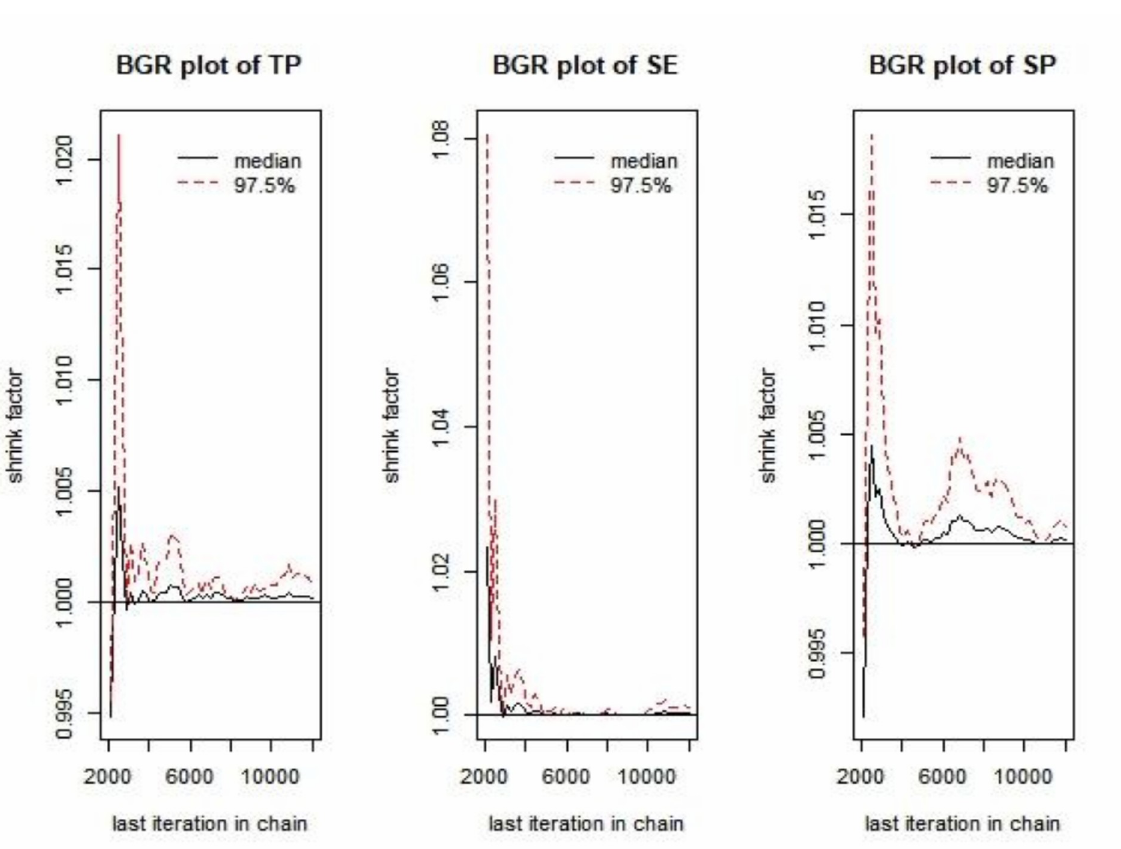
Fig 5. Brooks-Gelman-Rubin (BGR) plots for true prevalence (TP), sensitivity (SE) and specify (SP).